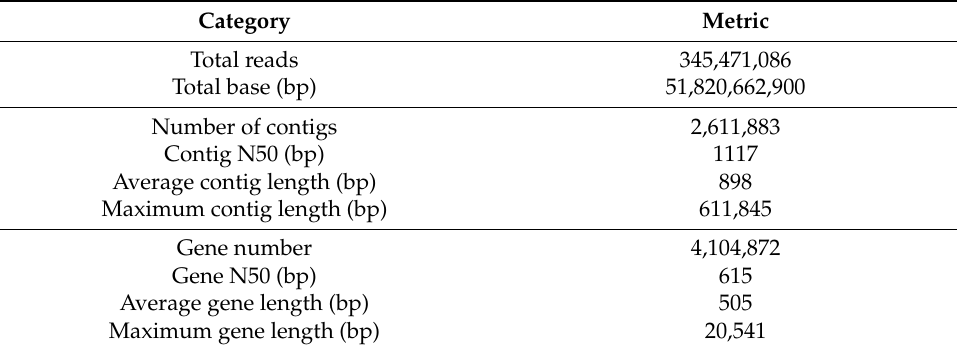
Table 1. Summary of metagenomic data obtained from the humus of Cuc Phuong tropical forest using Illumina HiSeq